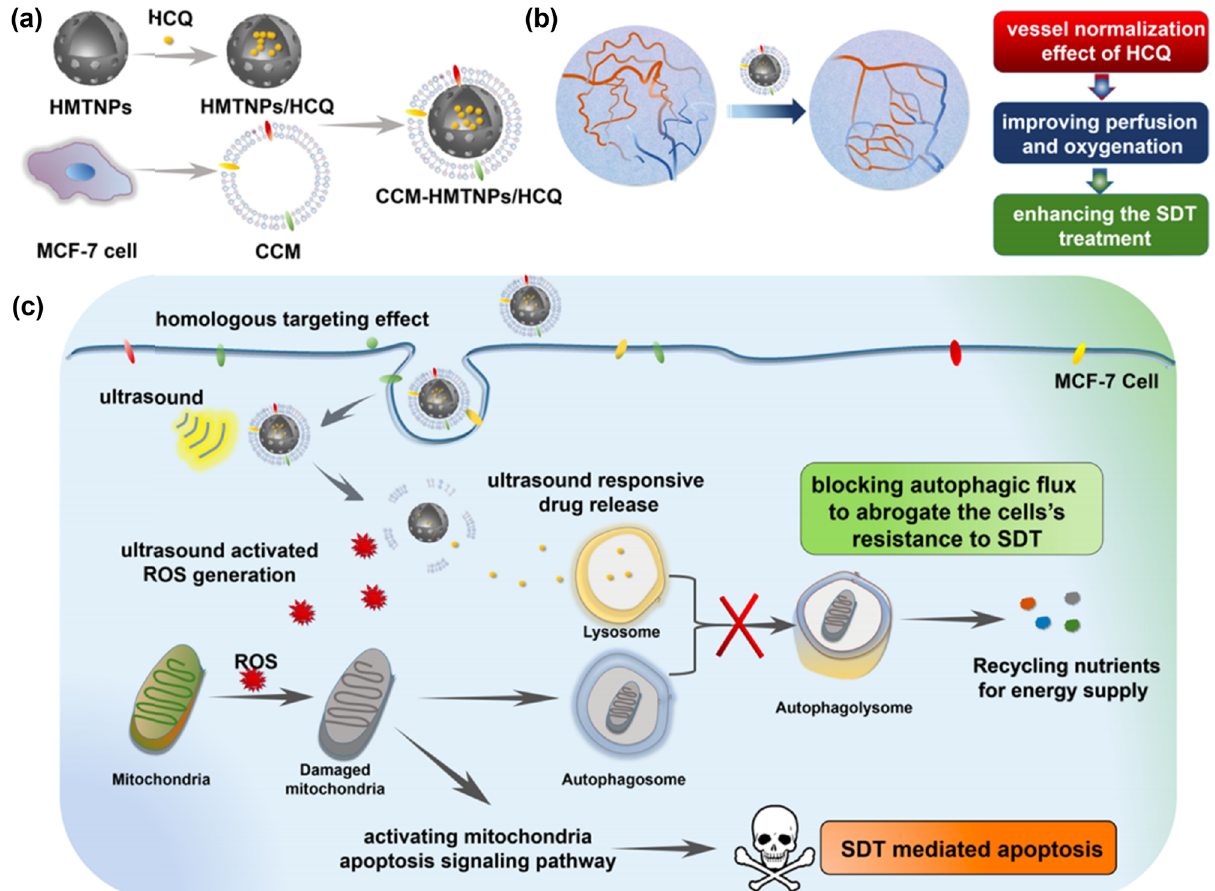
Figure 5: Treatment with CCM - HMTNPs/HCQ enhances SDT via the autophagy regulatory pathway ( a – c ) . Reprinted ( adapted ) with per - mission [ 38 ] . Copyright 2019 American Chemical